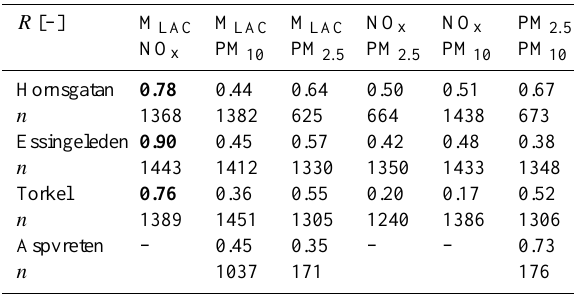
Table 4. Linear correlation coefficients between hourly concen- trations of different species measured at each site in the period 20 April–5 July 2006, but excluding the aerosol LRT event on 24 April–9 May 2006. n indicates the number of paired data for each combination. R> 0 . 75 are displayed in